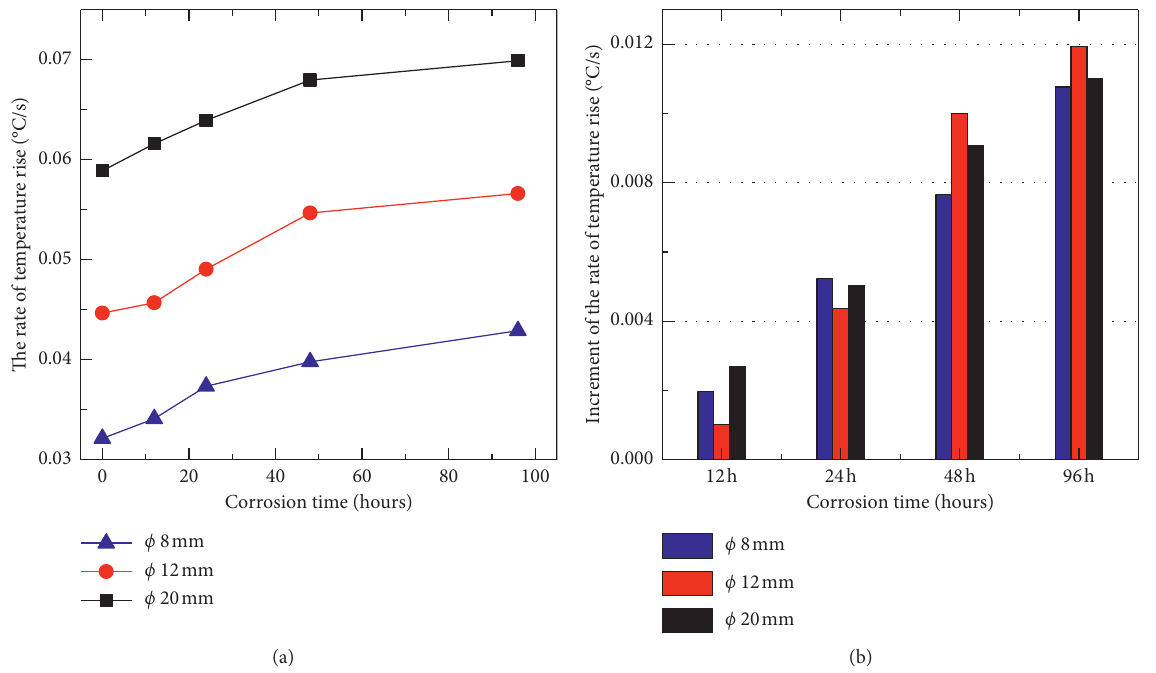
Figure 6: (a) The rate of the temperature rise and (b) its increment depends on the corrosion time of the specimens with different diameters of the internal steel bar.